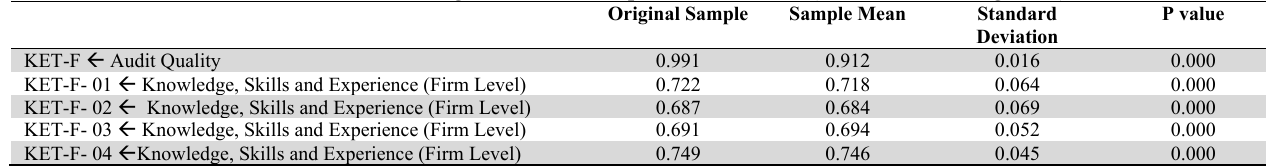
Original Sample Sample Mean